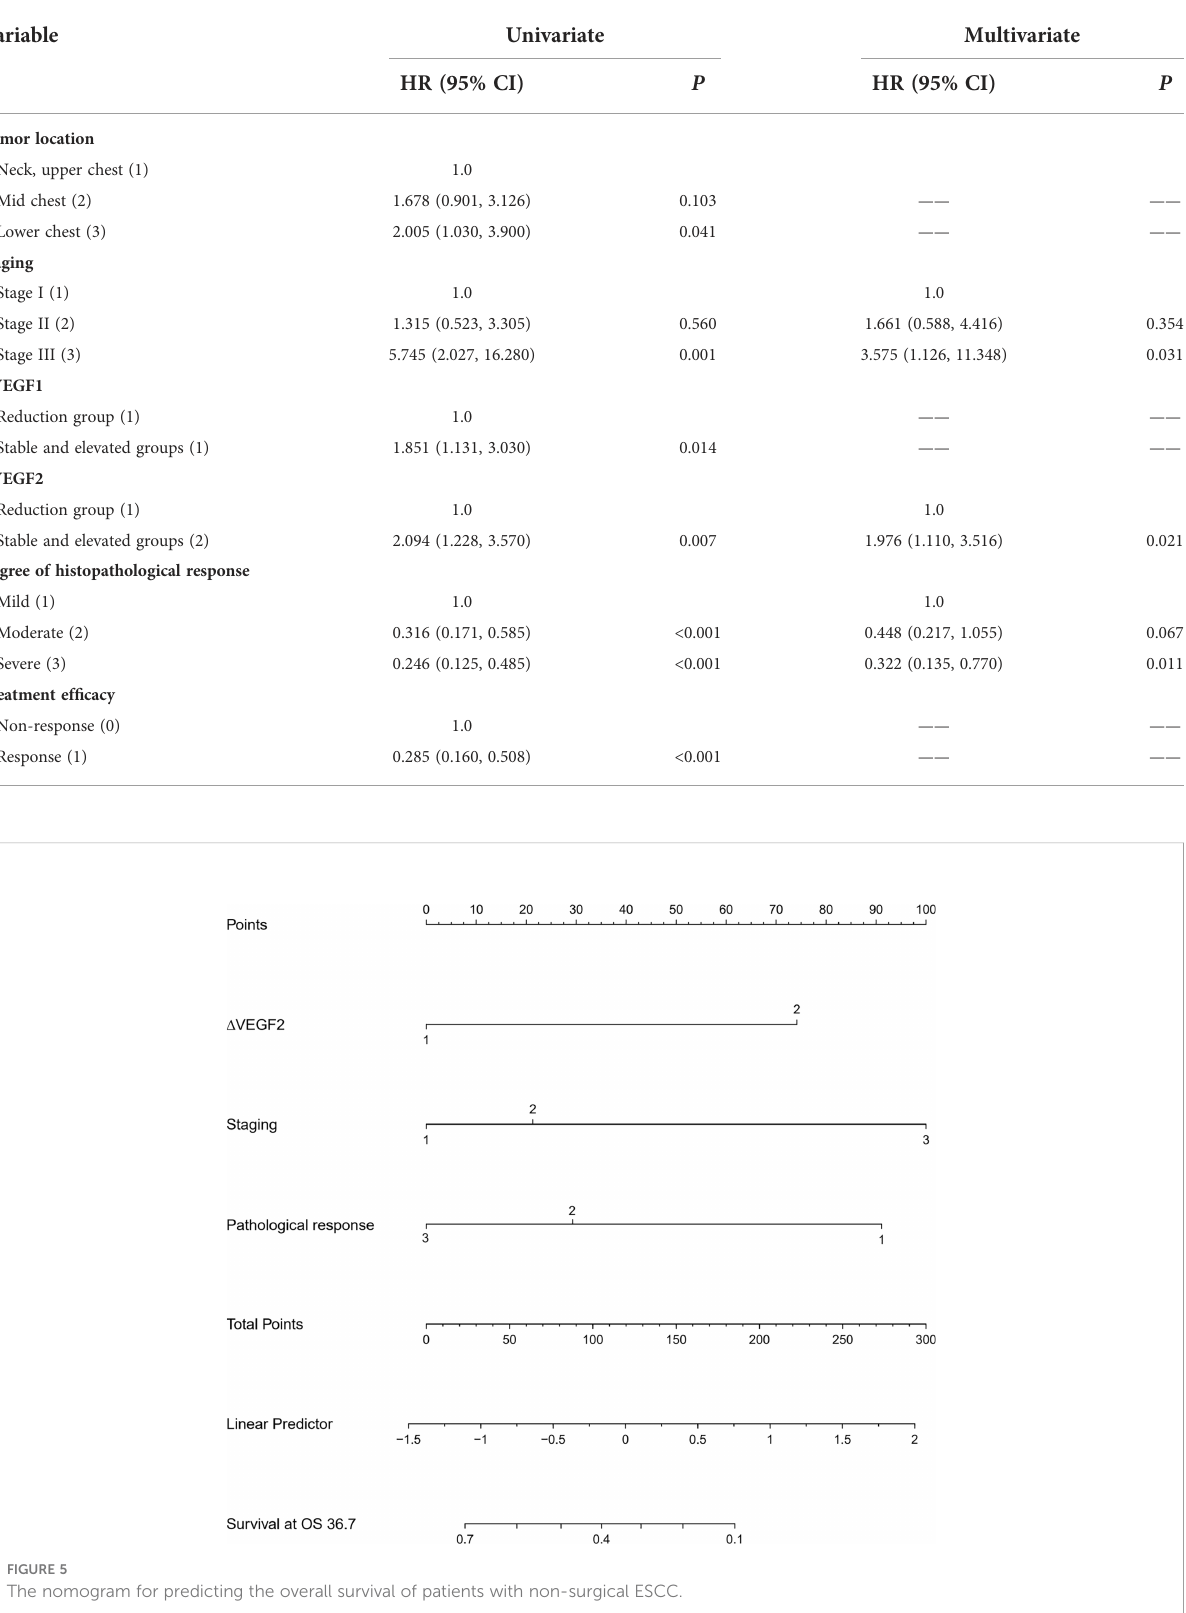
TABLE 5 Univariate and multivariate COX regression analysis of OS in patients with non-surgical ESCC.